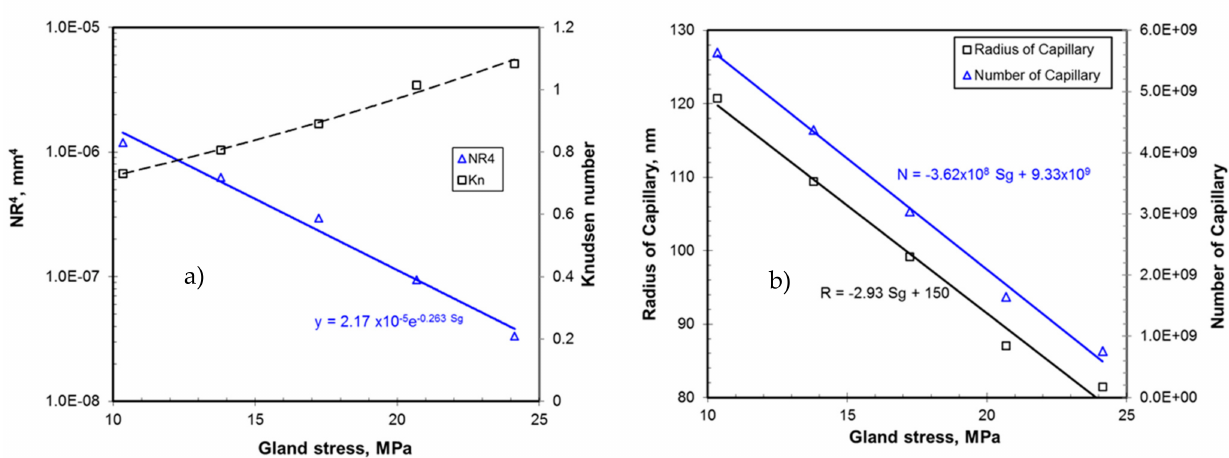
Figure 7. Variation of porosity parameters and Knudsen number for die